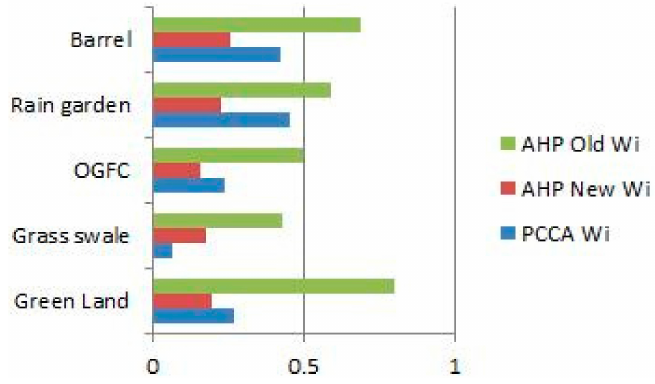
Figure 11. The weight of LID for the three analysis